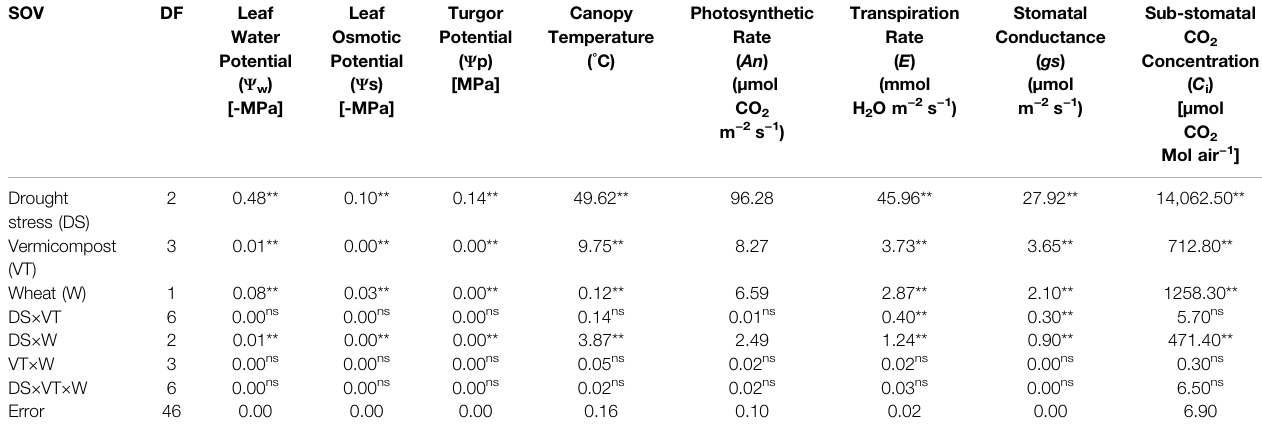
TABLE 4 | Mean sum of squares regarding the effect of soil-applied cellulolytic microbe-enriched rice straw vermicompost on the physiological attributes of wheat cultivars under different drought levels. SOV